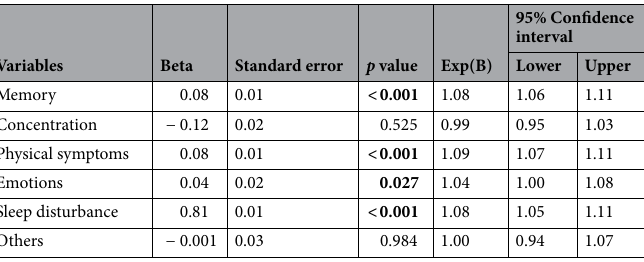
Table 2. Symptoms of probable dementia. Significant values are in